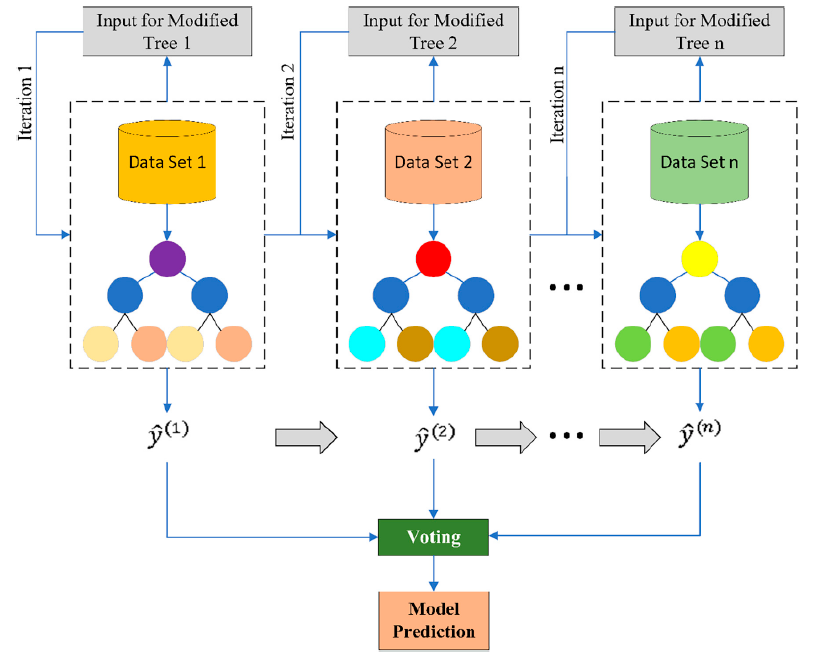
Figure 9. XGBoost schematic representation.